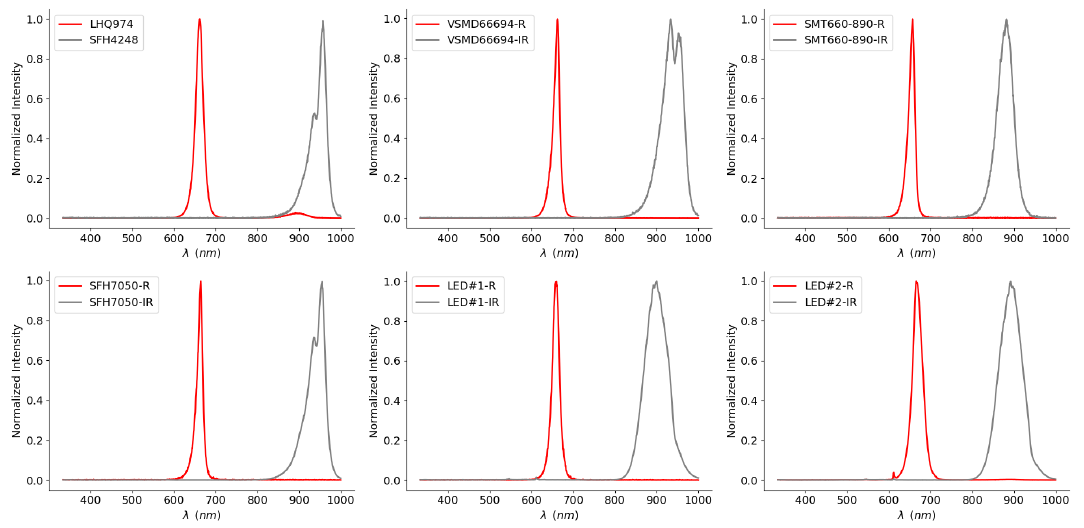
Figure 8. Measured distribution spectra of our light sources by Red–IR